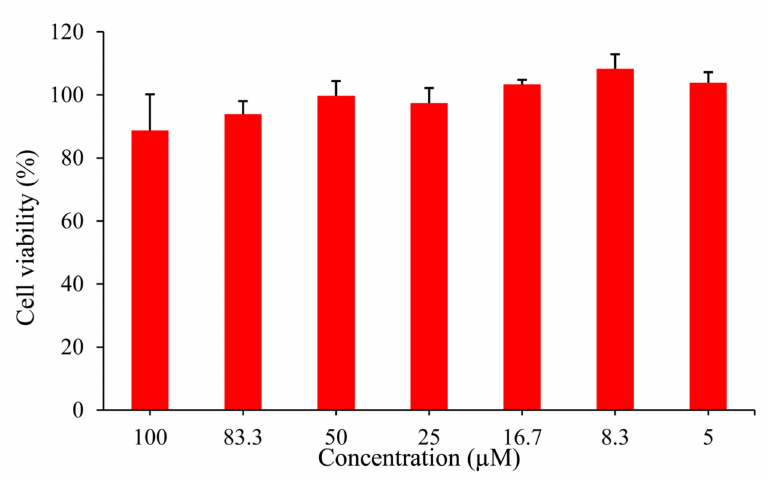
Figure 5. CCK8 assay of HepG2 cells incubated in the probe EB (0–100 µ M) at 37 ◦ C for 24